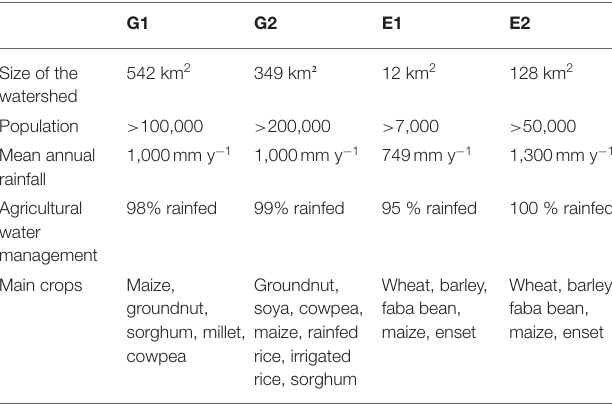
TABLE 2 | Characteristics of the selected watersheds (Oguntunde et al., 2006; Ghana Statistical Service, 2015; Mul et al., 2015; Adimassu, 2016; Kadyampakeni et al.,